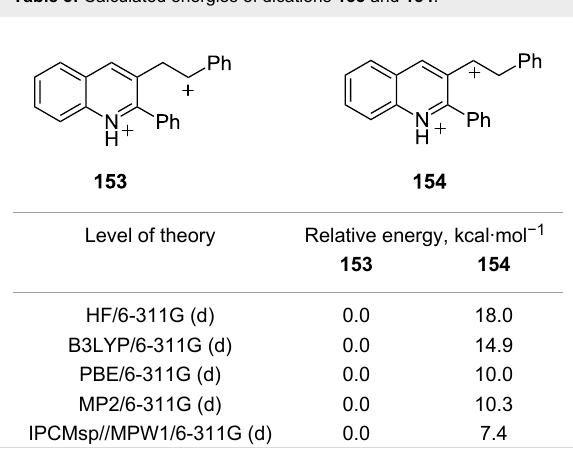
Table 3: Calculated energies of dications 153 and 154